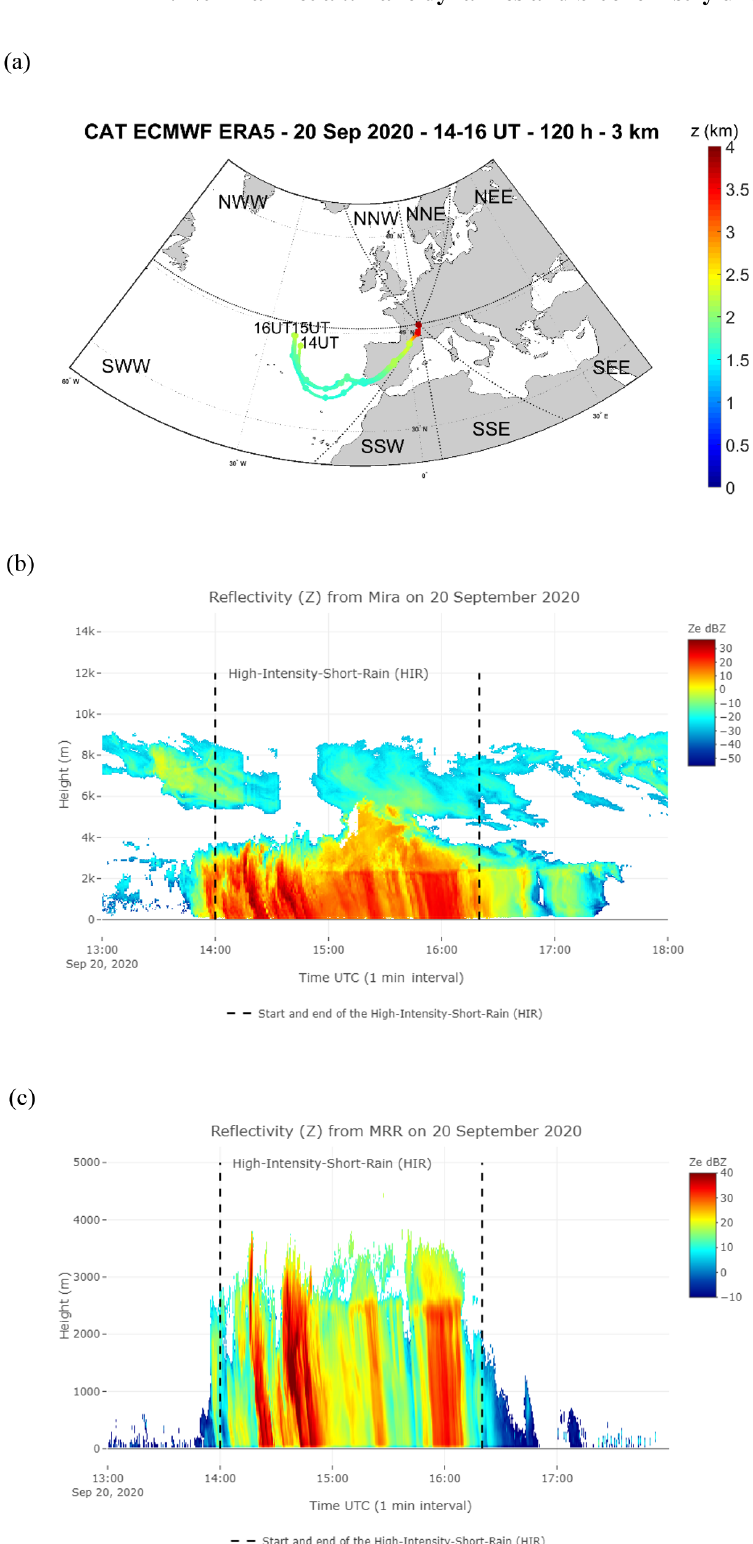
Figure 3. (a) Average of the backward trajectory of 120 clusters calculated every hour, the circles corresponding to the mean calculated every 12h during HIR on 20 September from 14:00 to 16:00UTC at 3km altitude from the ground level. Time series of vertical profiles of radar equivalent reflectivity from Mira35c on 20 September from 13:00 to 18:00UTC (b) , and with a temporal resolution of 5s from MRR (c)